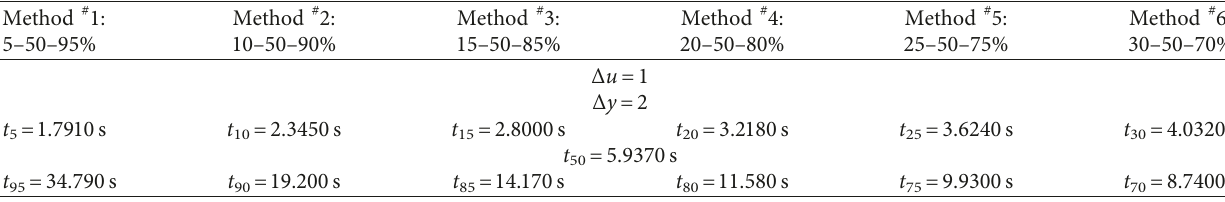
Table 20: Process information for fractional-order model identification of process P